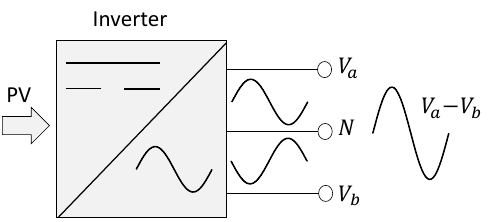
Figure 17. Block diagram of a typical residential inverter split-phase connection.